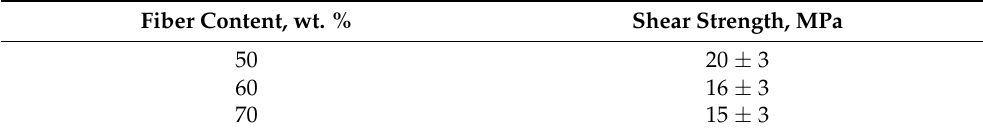
Table 2. Results of interlaminar shear strength tests. Fiber Content, wt.